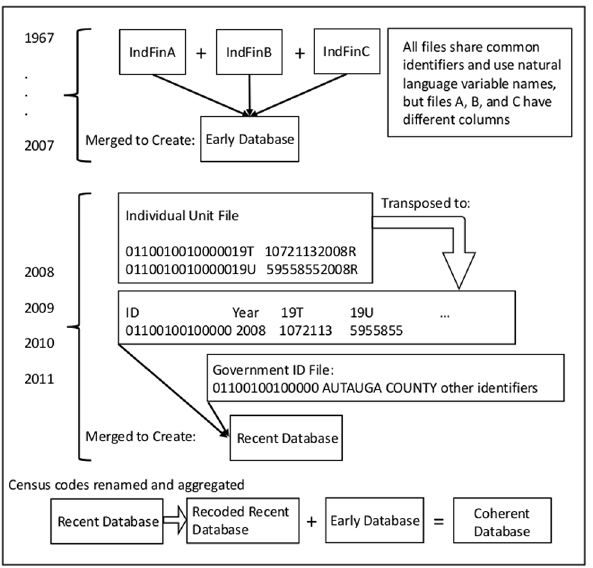
Fig 2. Consolidation of the Census of Governments Data. A conceptual overview of the process of consolidating the various data files to form a single coherent database.